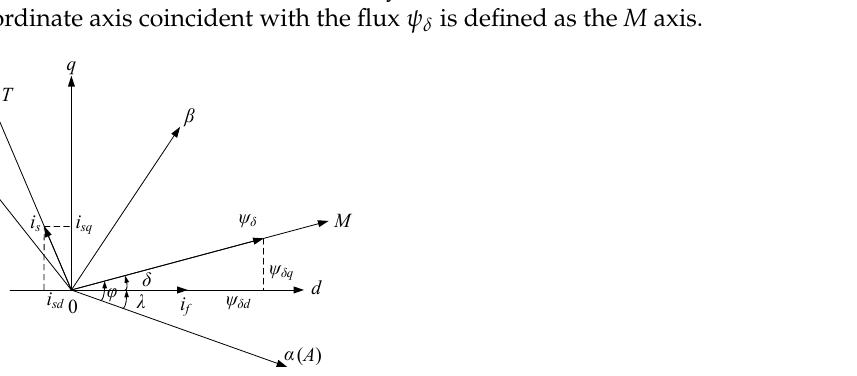
Figure 1. Reference coordinates of the synchronous motor.